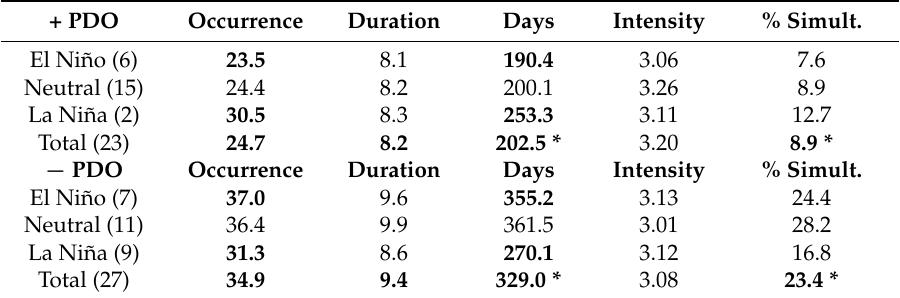
Table 4. Character of NH blocking events per year as a function of ENSO and PDO. The number of years in each category is shown in parenthesis. Bold numbers are statistical significance at the 90% confidence level and an (*) represents statistical significance at the 95% confidence level. + PDO Occurrence Duration Days Intensity %